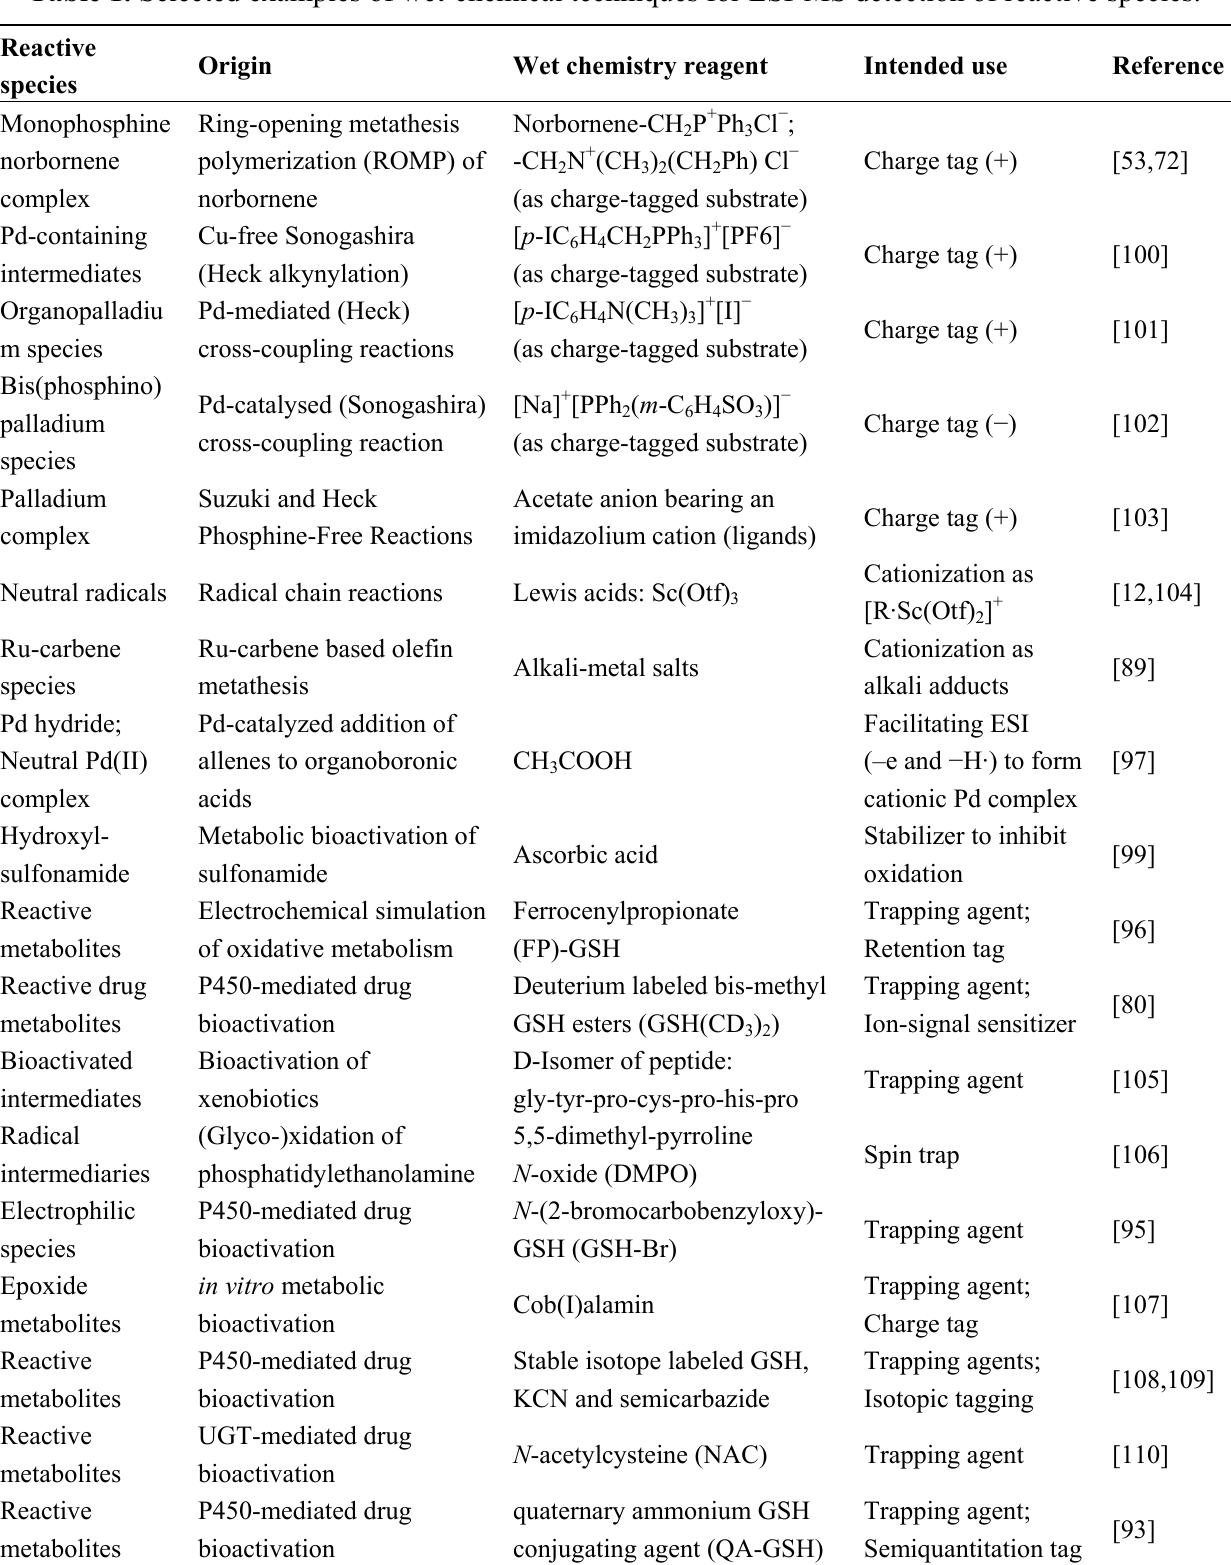
Table 1. Selected examples of wet-chemical techniques for ESI-MS detection of reactive species.